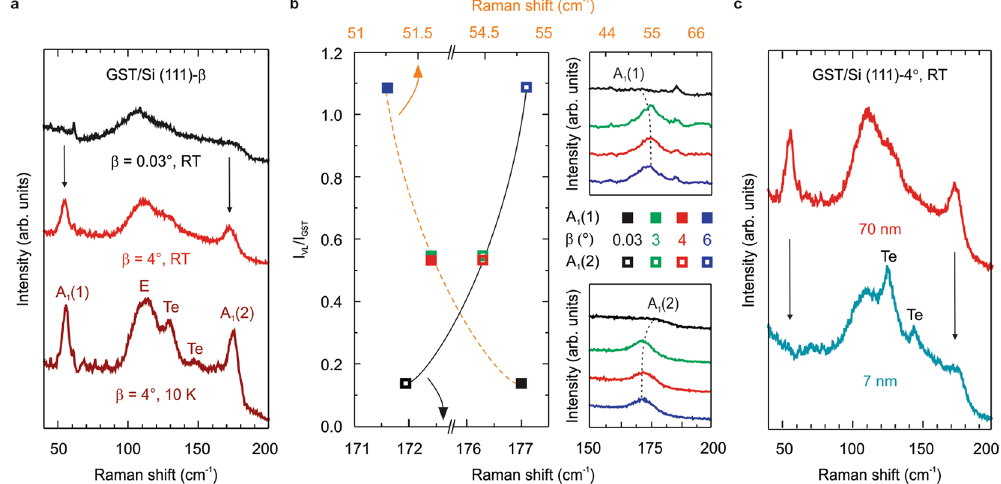
Figure 4. Stable rhombohedral stacking with almost pure GST124 on substrate miscut. ( a ) Raman spectra of 70 nm-thick GST grown on Si (111) with β = 0.03° at RT (black), β = 4° at RT (red) and β = 4° at 10 K (dark red). ( b ) Intensity ratio of the second order XRD for the VL peak and GST peak (I VL /I GST ) as a function of the Raman shift for the A 1 (1) (full squares) and A 1 (2) (empty squares) modes with β = 0.03° (black), 3° (green), 4° (red) and 6° (blue). Dashed and solid lines serve as a guide to the eye. The top and bottom right panels show the Raman shift of the A 1 (1) and A 1 (2) modes, respectively. ( c ) 70 nm- (red) or 7 nm- (light blue) thick GST grown on Si (111) with β =